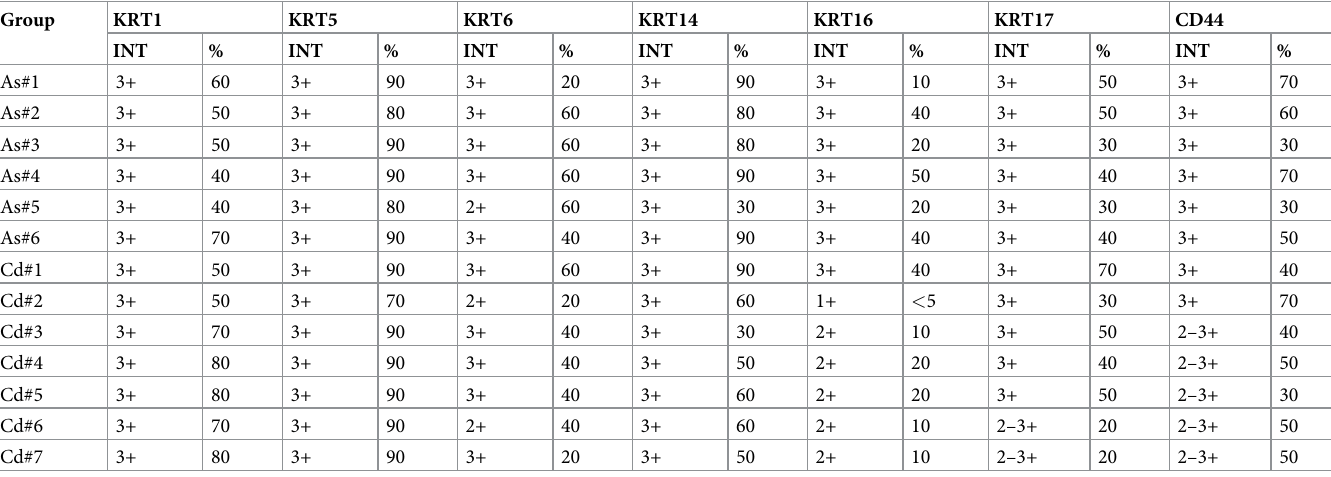
Table 1. Immunostaining of basal protein markers in As 3+ and Cd 2+ tumor transplants. Group